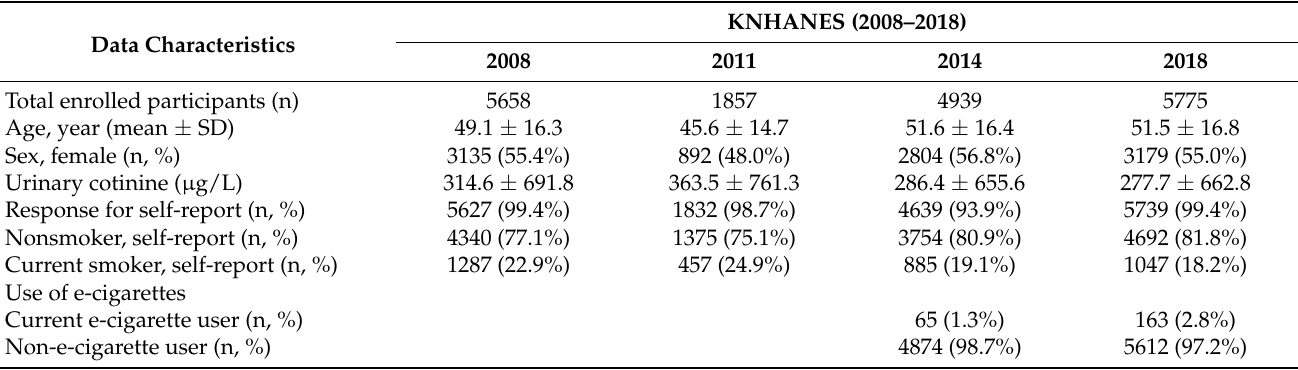
Table 1. The characteristics of study participants.